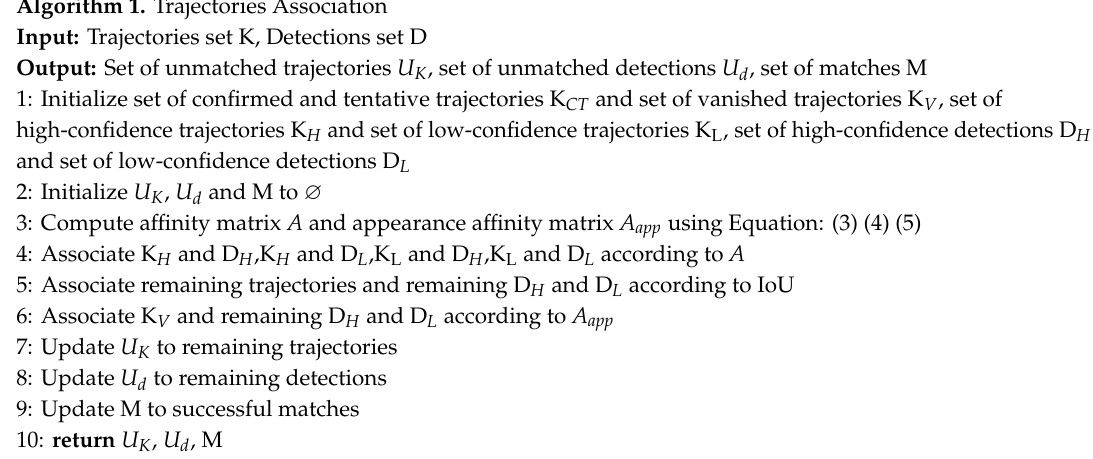
Algorithm 1. Trajectories